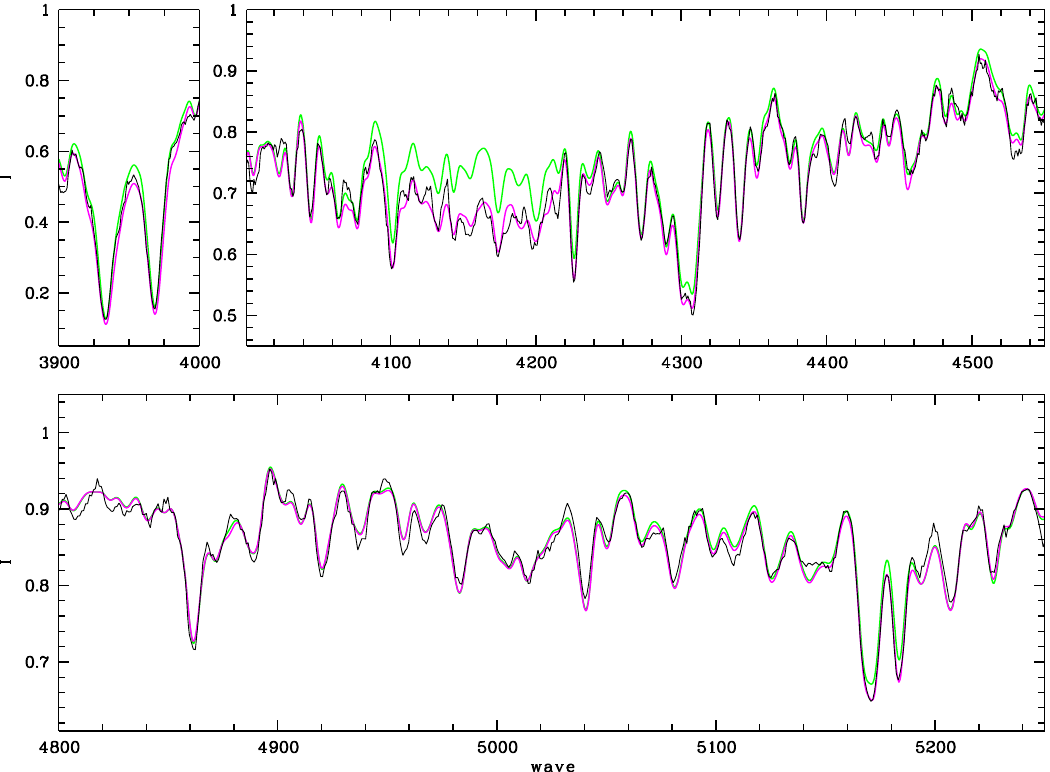
Figure 2: IL spectrum of Bol 6 from MMI21 ( in black ) in comparison with the synthetic one calculated using the isochrone from Pietrinferni et al . ( 2004 ) ( see Figure 1, panel a ) and the chemical composition de fi ned by MMI21 ( magenta ) . A synthetic spectrum with the modi fi ed chemical composition is shown in green with Ca, Mg, and C depleted by 0.2 dex and N depleted by 0.5